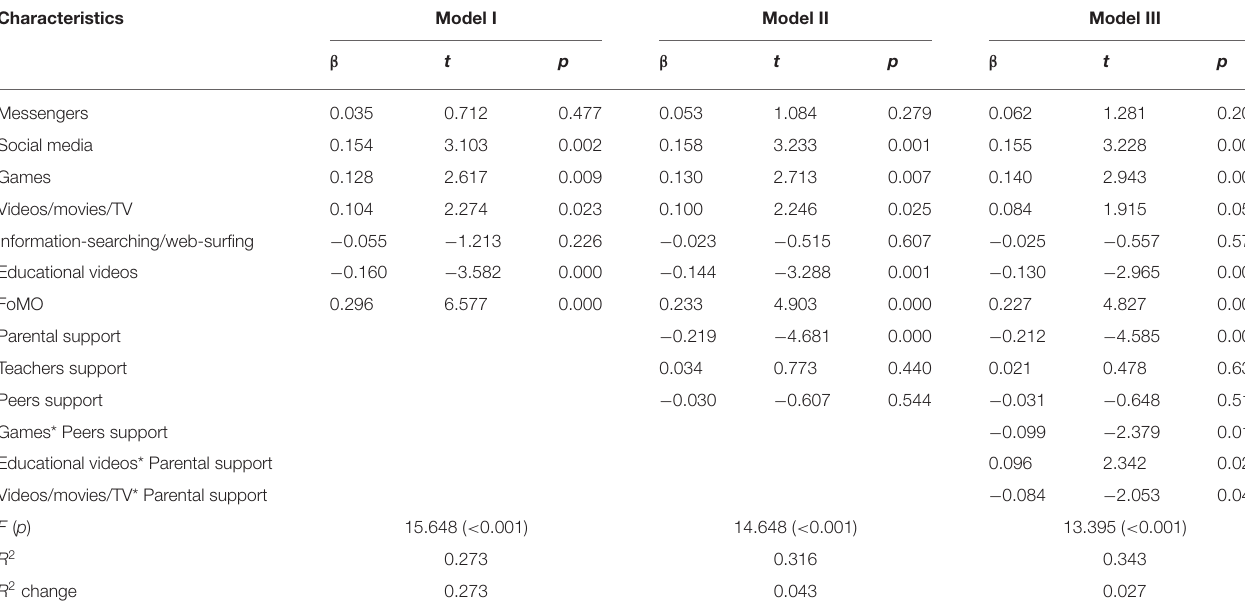
TABLE 4 | Hierarchical regression results to identify factors associated with smartphone screen time ( N = 428).